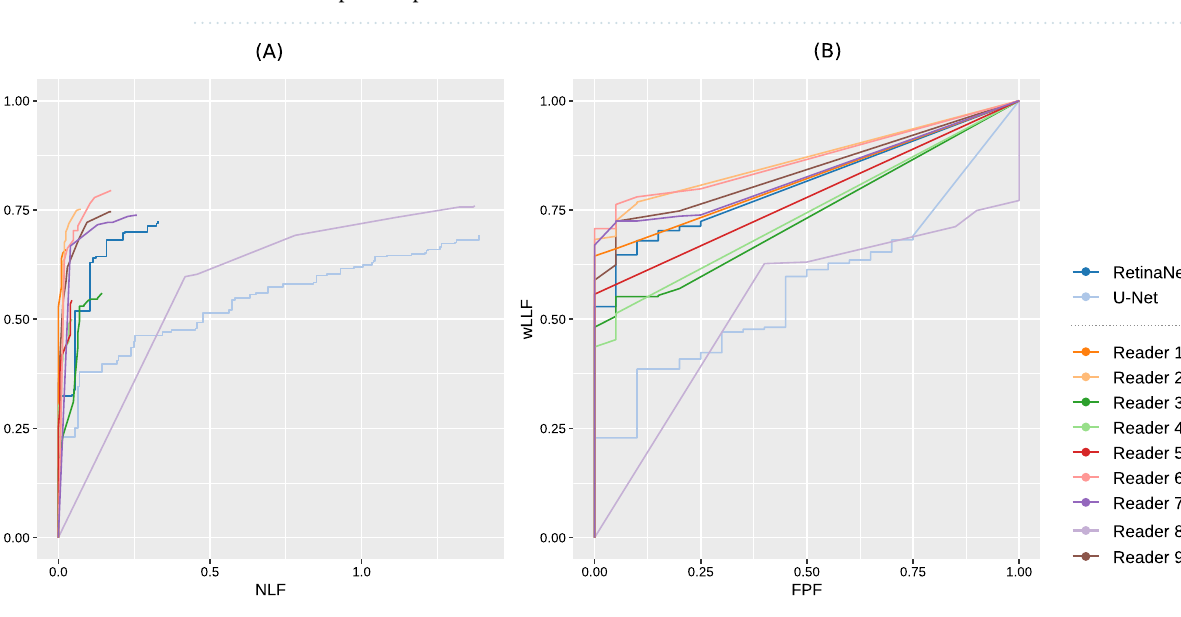
Figure 3. Comparison of CNN and reader based diagnostic performance. ( A ) FROC plot with lesion localization fraction (LLF) plotted against non lesion fraction (NLF) ( B ) wAFROC plot with weighted LLF on the ordinate. The plot was generated using RJafroc 26